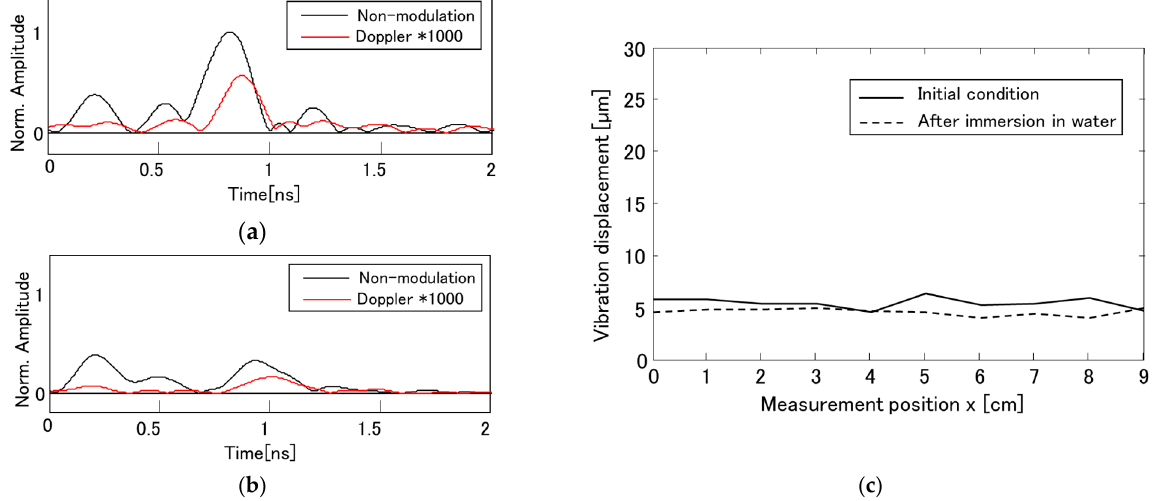
Figure 7. Results of Vibro-Doppler radar (VDR) measurement in concrete: ( a ) Envelope of VDR waveforms obtained for initial condition of test piece; ( b ) Envelope of VDR waveforms after immersion of test piece in water; ( c ) Vibration displacement of the rebar embedded in concrete.